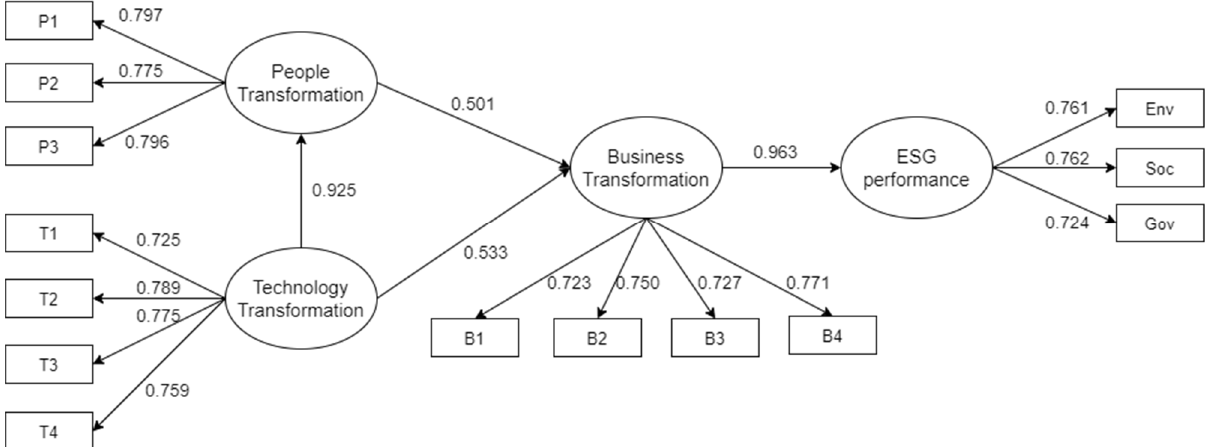
Figure 5. Path analysis result with Chi-square (X 2 ) = 74.396, degree of freedom (df) = 71, relative chi-square (X 2 /df) = 1.048, probability level = 0.368, GFI = 0.965, NFI = 0.970, CFI = 0.999, TLI = 0.998, RMR = 0.002, and RMSEA = 0.013.